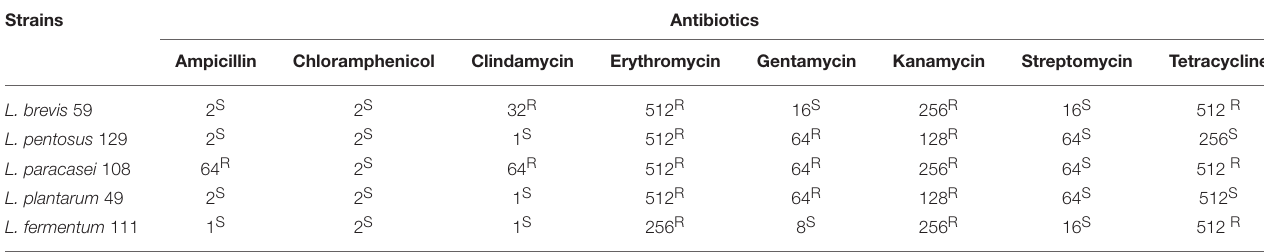
TABLE 4 | MIC of different antibiotics against different lactobacilli strains from pulp fruit processing byproducts. Strains